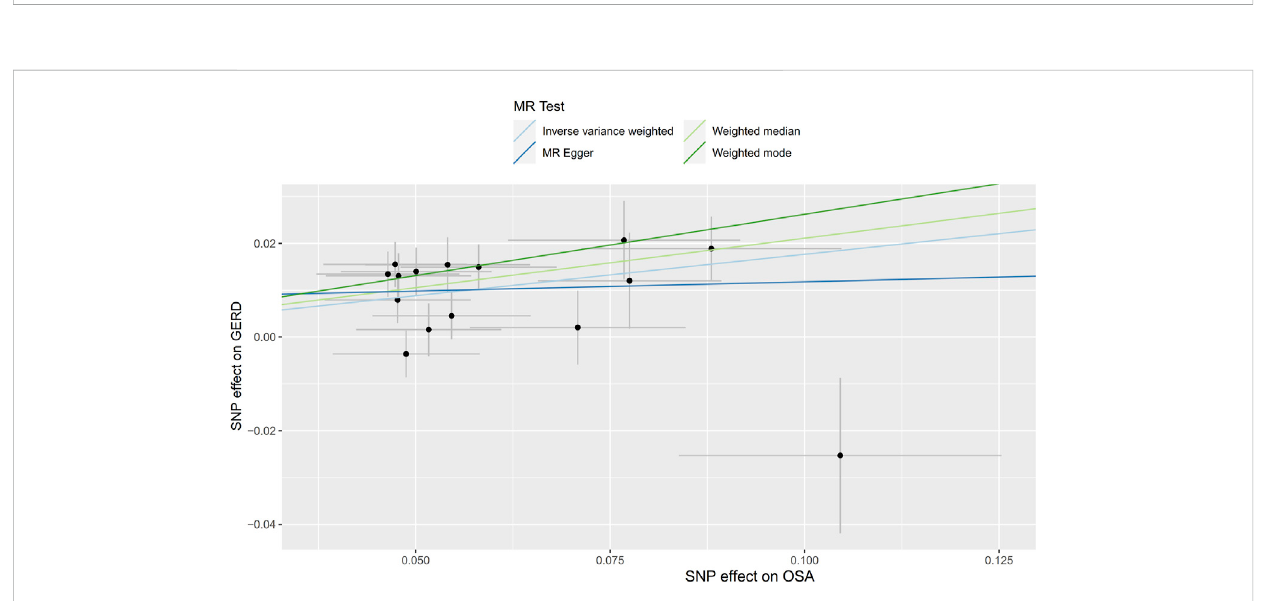
FIGURE 3 Scatter plot for the causal relationship of OSA on GERD. MR, Mendelian randomization; SNP, single nucleotide polymorphism; OSA, obstructive sleep apnea; GERD, gastroesophageal re fl ux